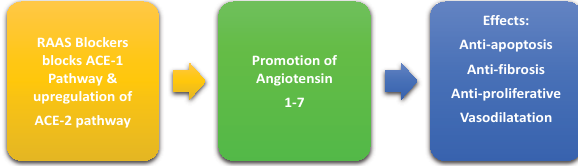
Figure 5:Benefi cial Eff ect of RAAS blockers on